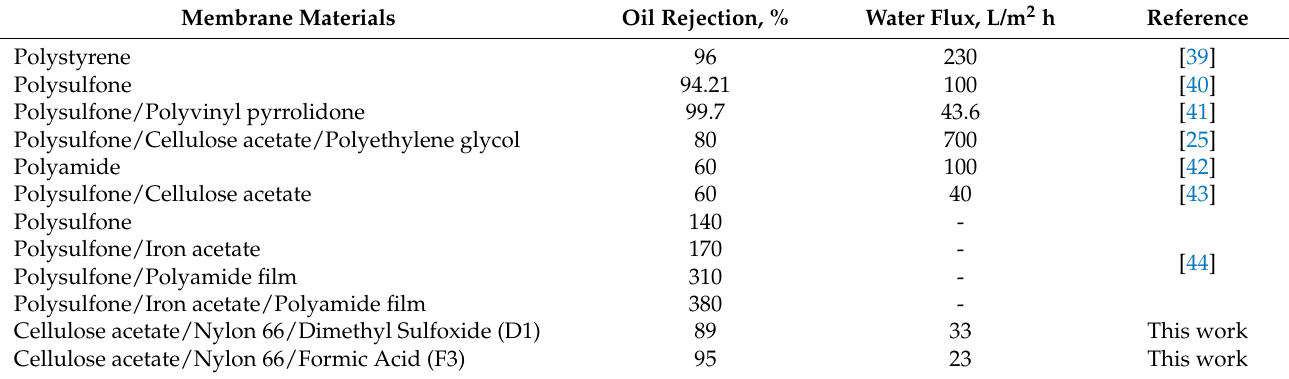
Table 4. Comparison of experimental results with other membranes .